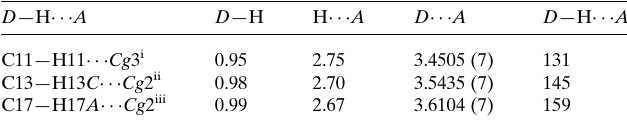
Table 1 Hydrogen-bond geometry (A˚ , (cid:3) ).